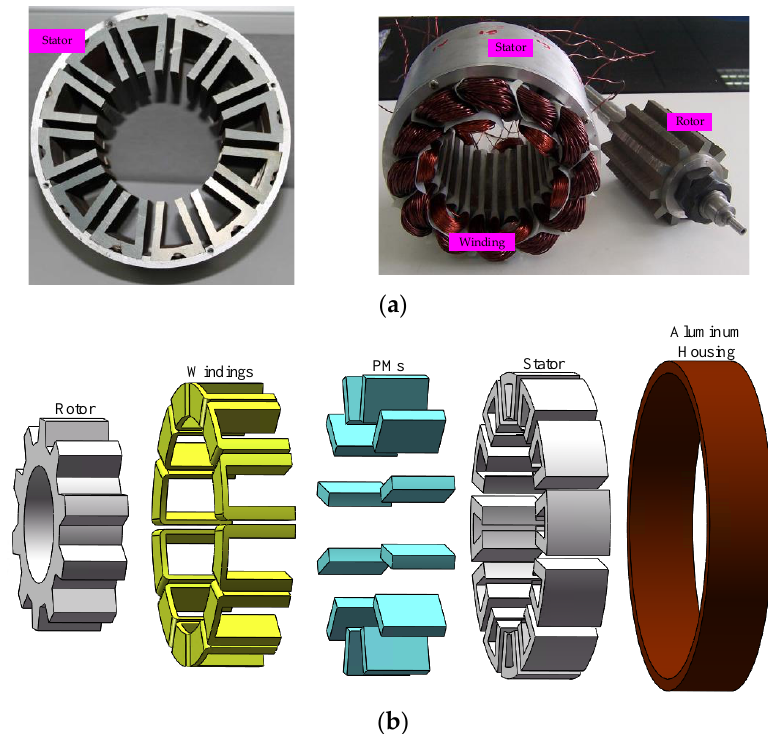
Figure 10. Assembling diagram of 12 / 10 FSPM machine. ( a ) Prototype. ( b ) 3D model. Table 1. Main dimensions and performance parameters of the flux switching permanent magnet (FSPM) machine. Parameters.